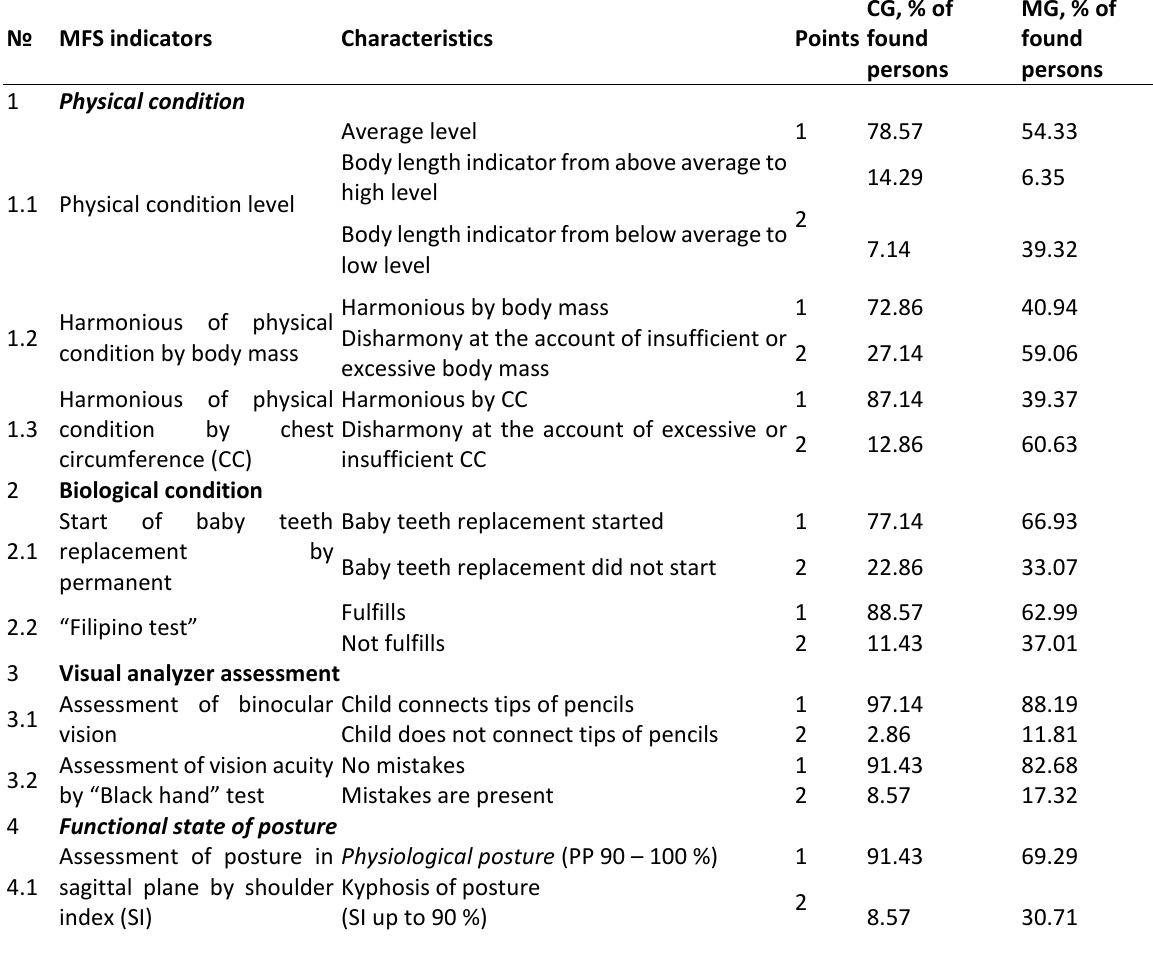
Table 4. Children’s